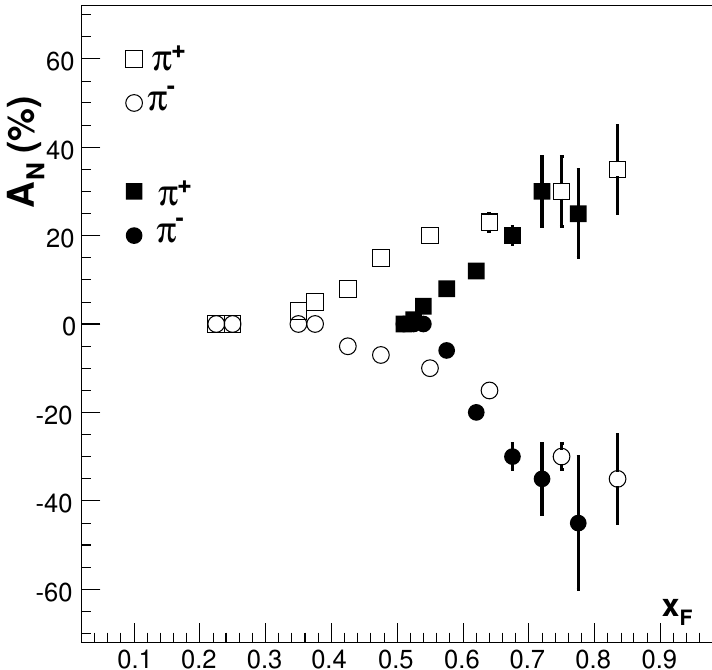
Figure 1. Experimental data on the asymmetry of the production of charged pions at low p b = (cid:112) S p , p = 6 . 4 GeV (see [7]) and high p b = 200 GeV / c (closed symbols), 21 . 6 GeV / c (open symbols), (cid:112) S p , p = 19 . 4 GeV [5] energies. (data taken from